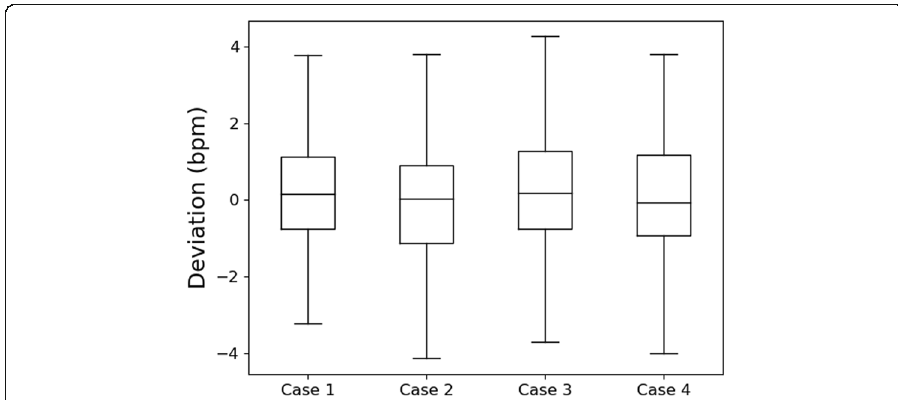
Fig. 4 Box plot of deviations between the proposed method of respiratory rate measurement and manual counts, across 4 cases (see Table 2)